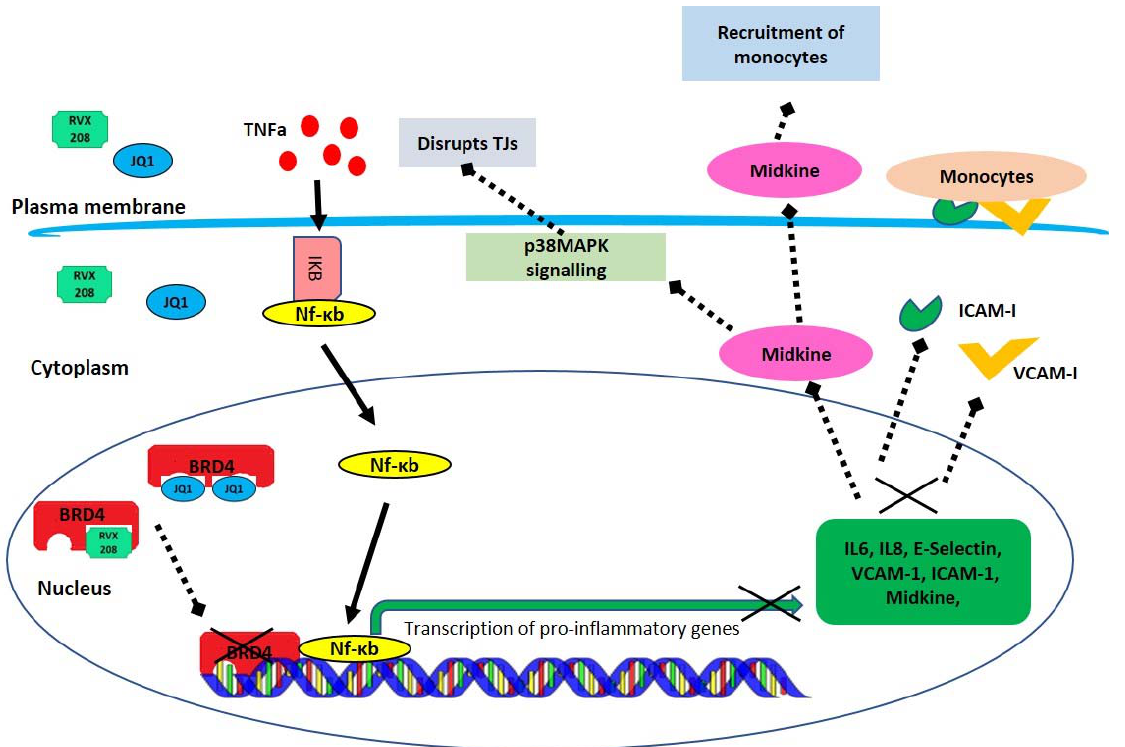
Figure 8. BRD4 inhibition reduces the expression of proinflammatory markers in ECs. Inflammatory stimuli (TNF- α ) induces activation and translocation of NF- κ B into nucleus. NF- κ B, along with BRD4 protein, transcribe proinflammatory markers, including (1) I-CAM, and VCAM-I, which express on ECs monolayer and bind to monocytes from blood and (2) midkine, which contributes to recruitment of monocytes, activates p38MAPK-mediated disruption of tight junctions in ECs, and increases the permeability of ECs monolayer. Small molecular inhibitors of BRD4 bind to BRD4 bromodomains and inhibit its binding to chromatin, which reduces the expression of proinflammatory markers and midkine and protects ECs from dysfunction and tight junction disruption.